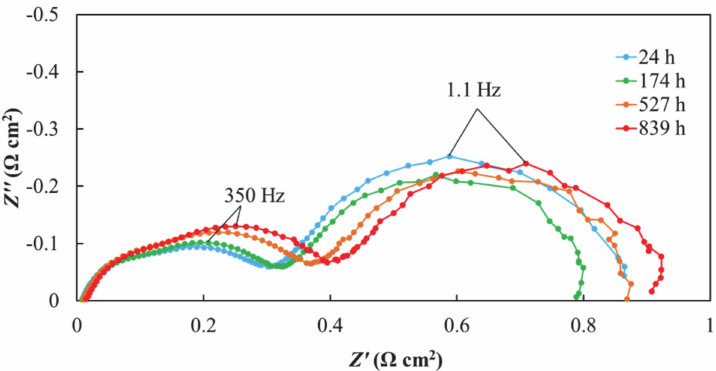
Figure 8. Dependence of polarization impedance of Ni-YSZ|YSZ|GDC|PSC short stack on time measured in electrolysis mode. T = 800 ◦ C, E = 1.2 V. Measured at 4 different operation times, which are noted in the figure.